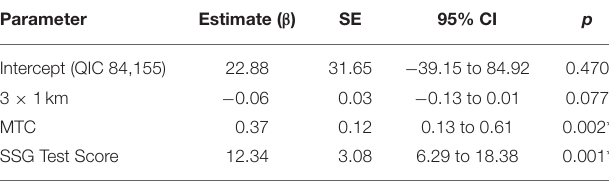
TABLE 3 | Multivariate generalized estimating equations for prediction of disposal efficiency ( n =